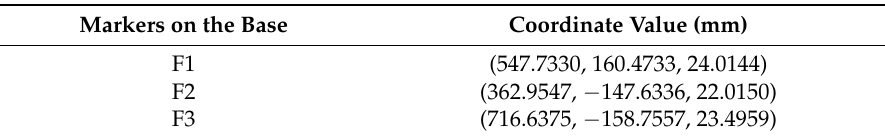
Table 5. The coordinate values of the markers on the base.